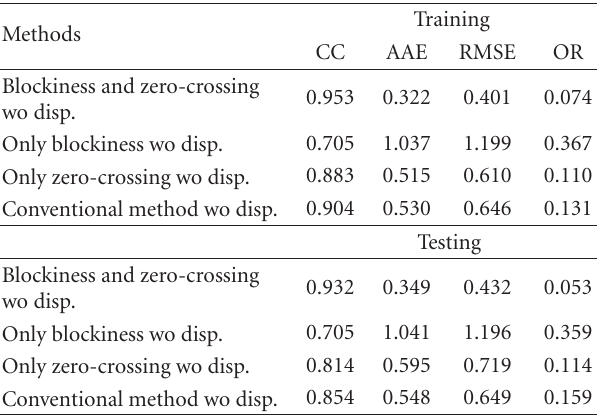
Conventional method wo disp.